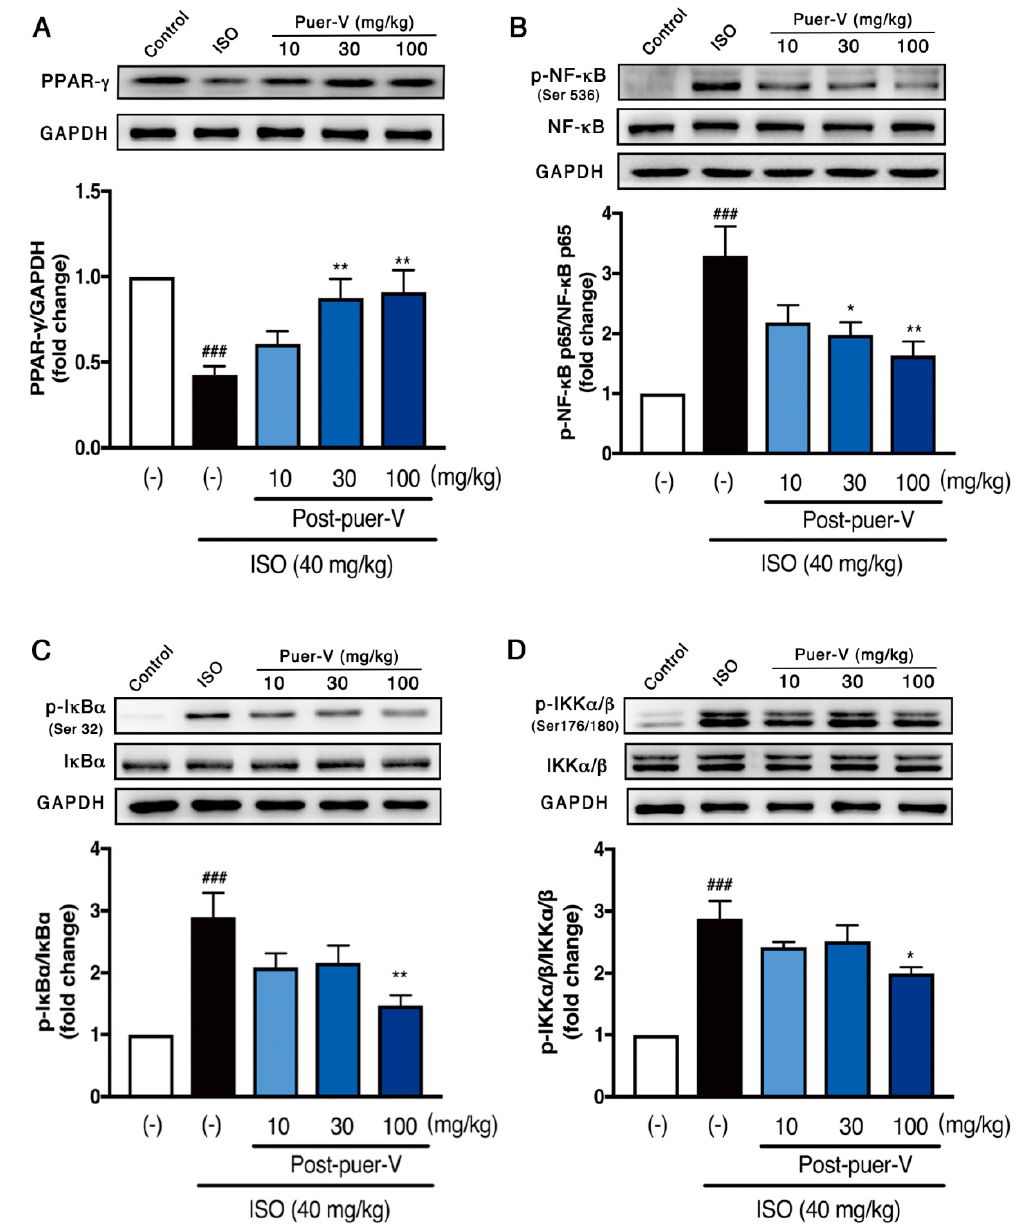
Figure 6. Puerarin-V attenuated ISO-induced inflammation in the MI mice associated with the PPAR- γ /NF- κ B pathway: ( A ) PPAR- γ ; ( B ) p-NF- κ B/NF- κ B; ( C ) p-I κ B- α /I κ B- α ; and ( D ) p-IKK α / β /IKK α / β . Relative density analysis of the protein bands was shown by the western blot with GAPDH as control. Data are shown as mean ± SEM ( n = 6). ### p < 0.001 vs. control group. * p < 0.05, and ** p < 0.01 vs. model group.